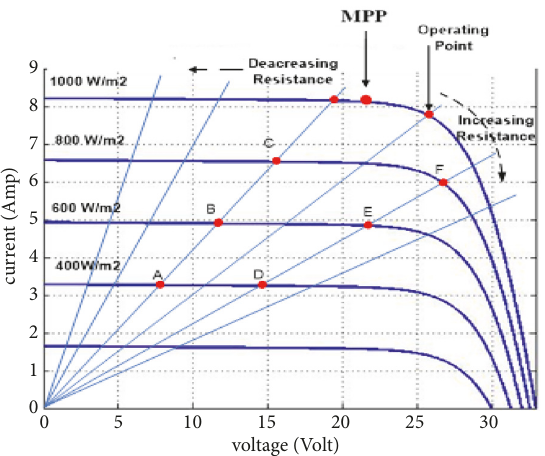
Figure 5: Effect of resistive load on cell operating point.